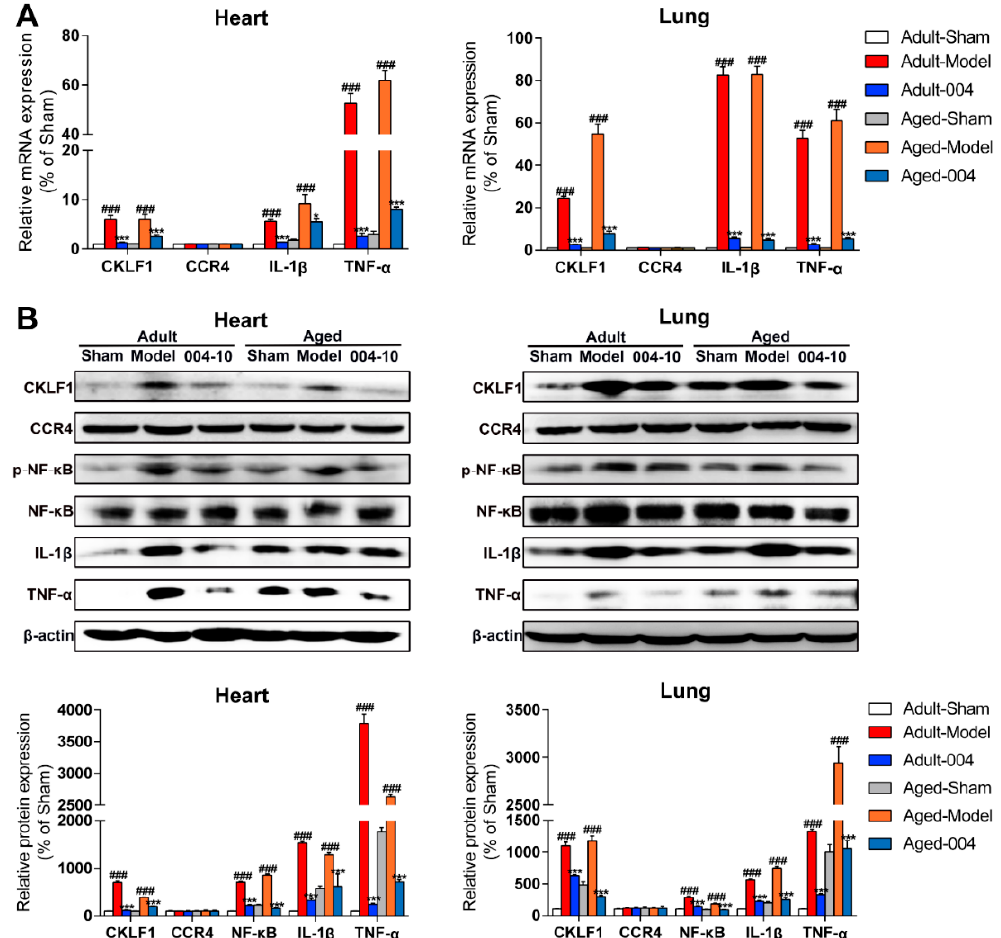
Figure 12. IMM-H004 decreases inflammation in heart and lung of aged rats. ( A ) Effect of IMM-H004 on aged rats heart and lung mRNA levels of CKLF1, CCR4, IL-1 β , and TNF- α as determined by quantitative RT-PCR. ( B ) Effect of IMM-H004 on the CKLF1, CCR4, IL-1 β , and TNF- α protein expression levels in aged rats heart and lung as assayed by Western blotting using a Gel-Pro analyzer (Media Cybernetics, Rockville, MD, USA). All the data are shown as the mean ± SD; part of data are shown as the mean ± SD after normalization to the sham ( n = 6/group). ### p < 0.001 vs. sham; * p < 0.05 vs. model; *** p < 0.001 vs. model.